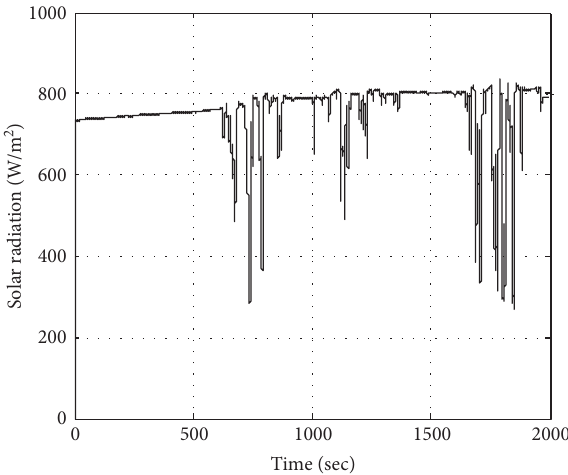
Figure 18: Evolution of solar radiation.